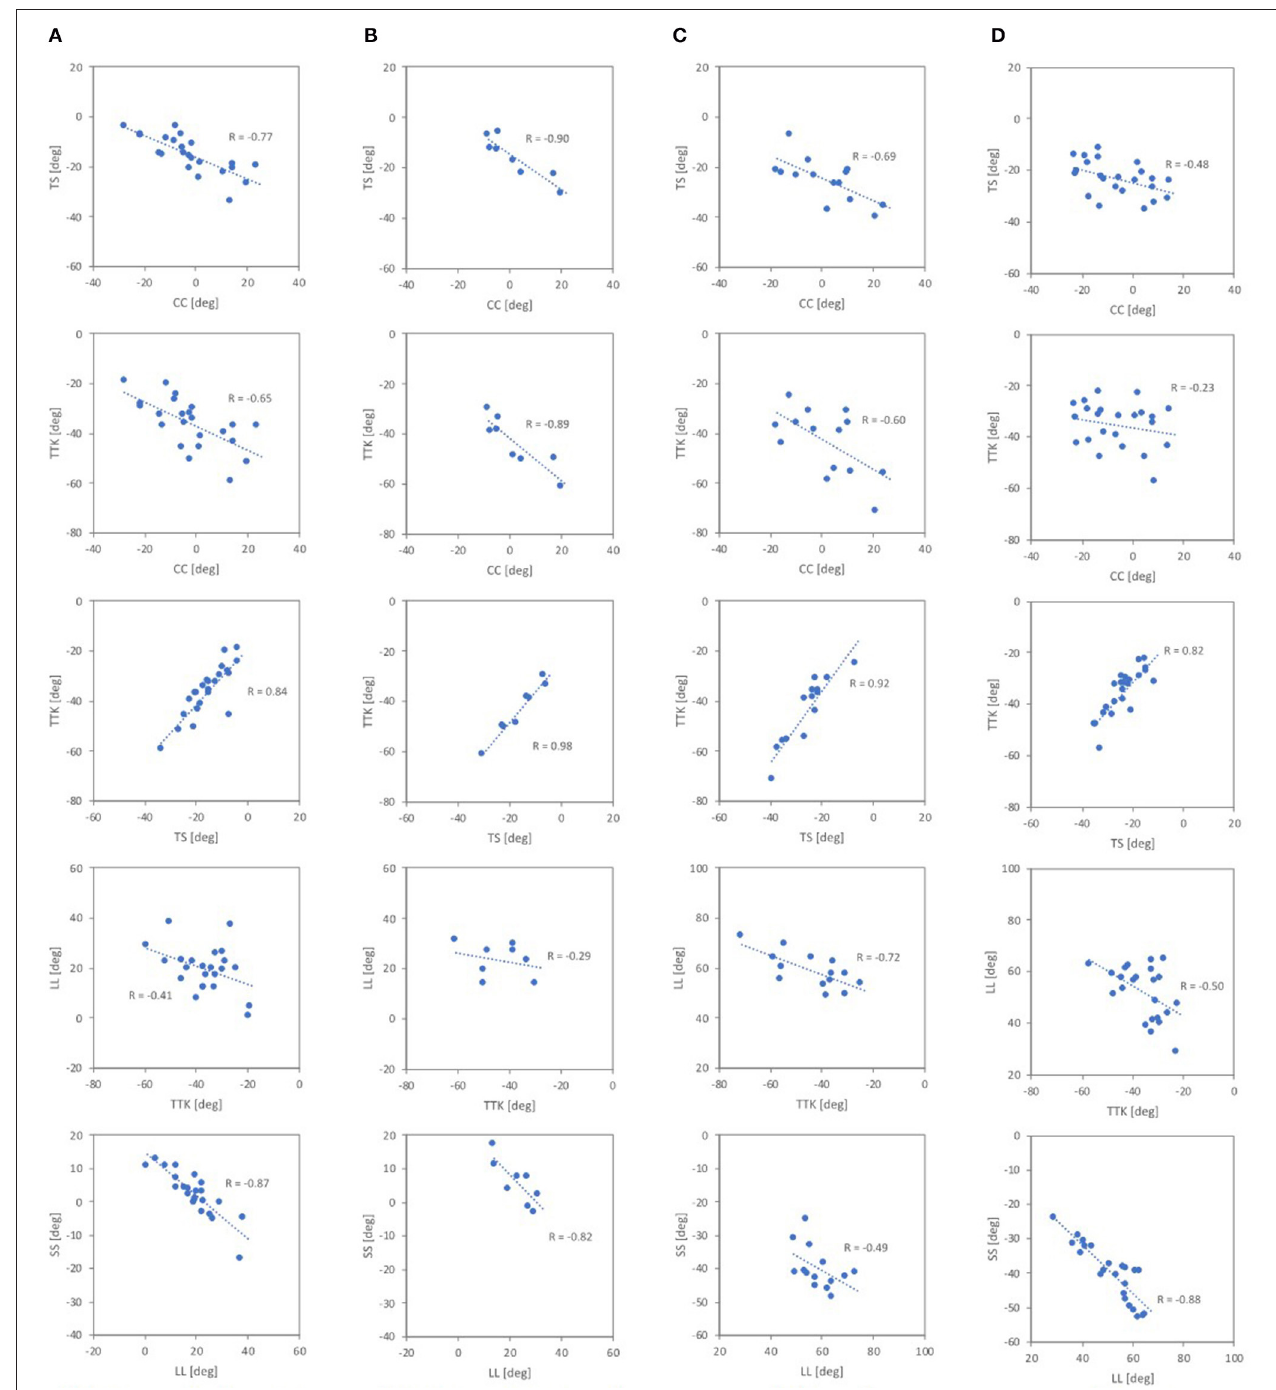
FIGURE 9 | Correlations between the spinal segmental angles. (A) 20 ◦ seat back angle, (B) 25 ◦ seat back angle, (C) standing, (D) supine.